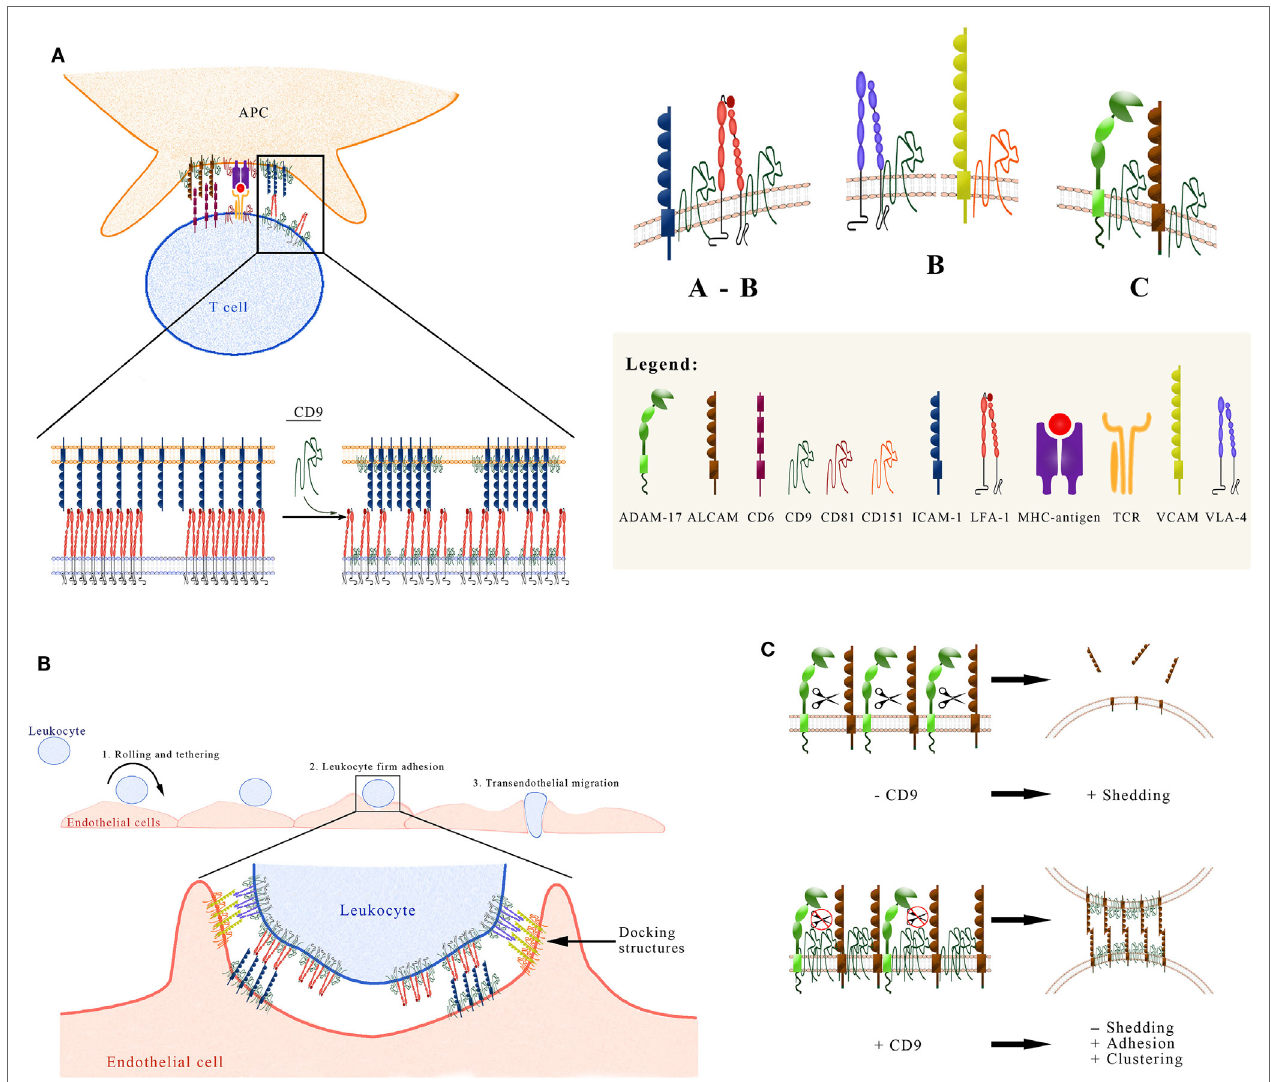
FiGURe 1 | Functional regulation exerted by CD9 on the activity of some immune system adhesion molecules. (A) CD9 regulates ICAM and lymphocyte function- associated antigen 1 (LFA-1) at the immune synapse (IS). Interactions between LFA-1 on the T cell, and its ligand intercellular adhesion molecule 1 (ICAM-1) on the APC surface, take place at the peripheral area of the IS (pSMAC) and are crucial for IS formation and stabilization. The tetraspanin CD9 plays an important role in the IS in two different ways: (1) Through its association with LFA-1 on the T cell, CD9 controls the state of aggregation and adhesive capacity of this integrin. Neoexpression/overexpresion of CD9 reduces the integrin adhesive capacity by generating a larger number of clusters of LFA-1 molecules that individually display a smaller size. (2) On the APC surface CD9 recruits ICAM-1 into TEMs, thus increasing its adhesive capacity. (B) CD9 regulates leukocyte firm adhesion on endothelial cells. The multi-step paradigm of the leukocyte extravasation cascade includes the initial tethering and rolling of the leukocyte on the endothelial surface, followed by the firm adhesion step and transmigration either between two endothelial cells or through the body of an endothelial cell. The firm adhesion step is mediated by the high-affinity interaction of leukocyte integrins LFA-1 ( α L β 2) and Mac-1 ( α M β 2) with their endothelial counter-receptor ICAM-1, and of integrin VLA-4 ( α 4 β 1) with its endothelial ligand VCAM-1. ICAM-1 and VCAM-1 are preorganized in endothelial adhesive platforms (EAPs), through their association with CD9 and CD151 respectively. After leukocyte binding, EAPs evolve into three-dimensional docking structures that emanate from the endothelial surface and embrace the leukocyte. (C) CD9 affects the shedding of leukocyte adhesion molecules mediated by ADAM17. The recruitment of ADAM17 into CD9-organized TEMs (low panel), following the overexpression or neoexpression of this tetraspanin, exerts a negative regulation on the sheddase activity of ADAM17 against different substrates on leukocytic cells, including activated leukocyte cell adhesion molecule (ALCAM). This negative regulation on ADAM17 activity accounts for an increased expression of ALCAM on the cell surface. Additionally, CD9 also induces the aggregation of ALCAM and the concomitant increase in its avidity. Therefore, CD9 augments ALCAM- mediated cell–cell adhesion through this dual